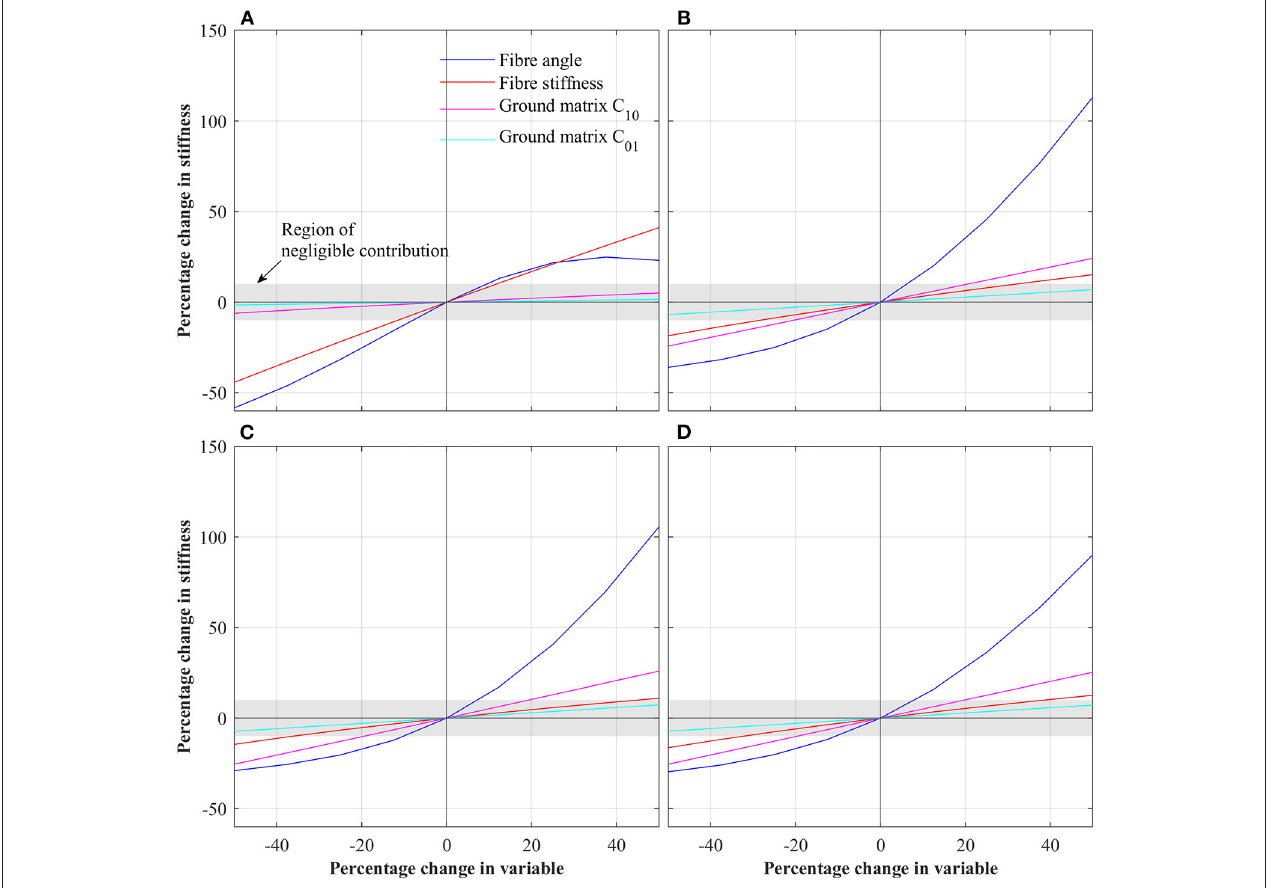
FIGURE 3 | Percentage change in IVD stiffness as a function of changing individual parameters for the different loading conditions. (A) Axial rotation. (B) Flexion. (C) Extension. (D) Lateral bending. ( Figures 4B,C ) this is represented by a stack of curves.